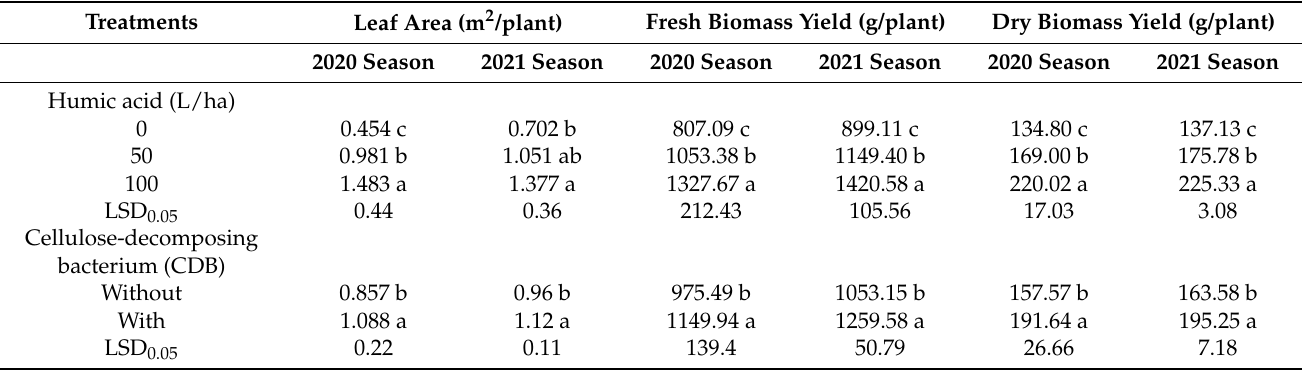
Table 1. Effects of humic acid, cellulose-decomposing bacterium and wheat straw levels on the leaf area, fresh and dry biomass yield of squash during the 2020 and 2021 planting seasons. Treatments Leaf Area (m 2 /plant) Fresh Biomass Yield (g/plant) Dry Biomass Yield